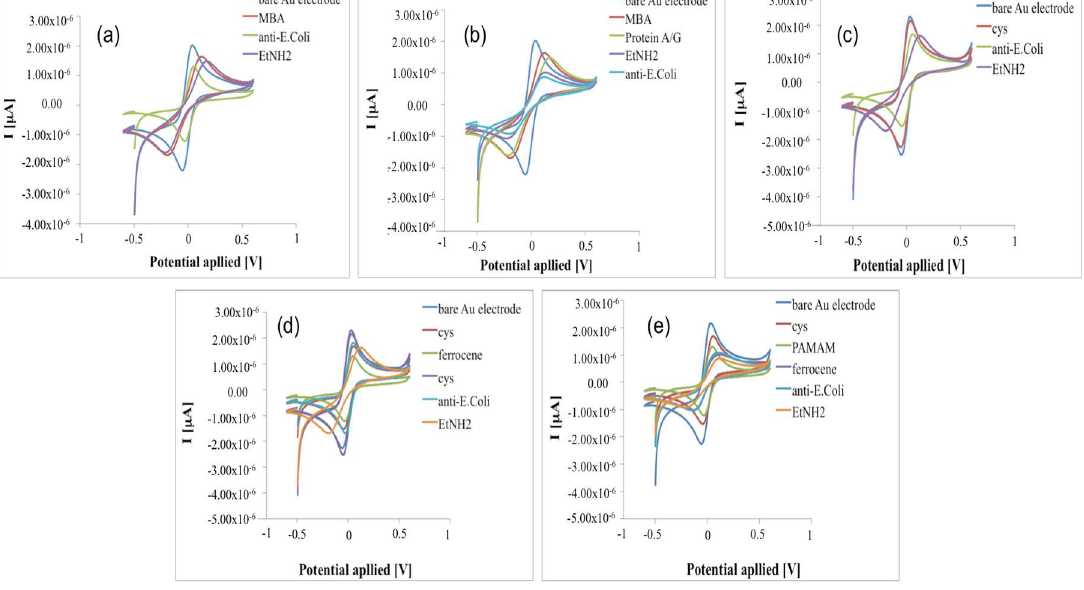
Figure 2. Cyclic Voltammograms in 1 mM K 3 [Fe(CN) 6 ]/K 4 [Fe(CN) 6 ] after each step of immunosensors construction for all immobilization schemes tested in this work: ( a ) Au-MBA-Ab; ( b ) Au-MBA- ProteinA/G-Ab; ( c ) Au-Cys-Ab; ( d ) Au-Cys-Ferrocene-Ab; ( e ) Au-Cys-PAMAM- Ferrocene-Ab.